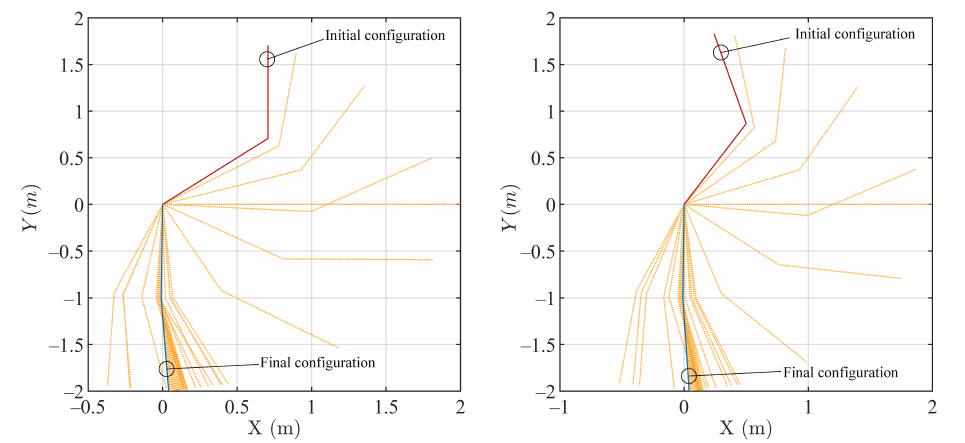
Figure 7. Task performances of the master and slave robots.